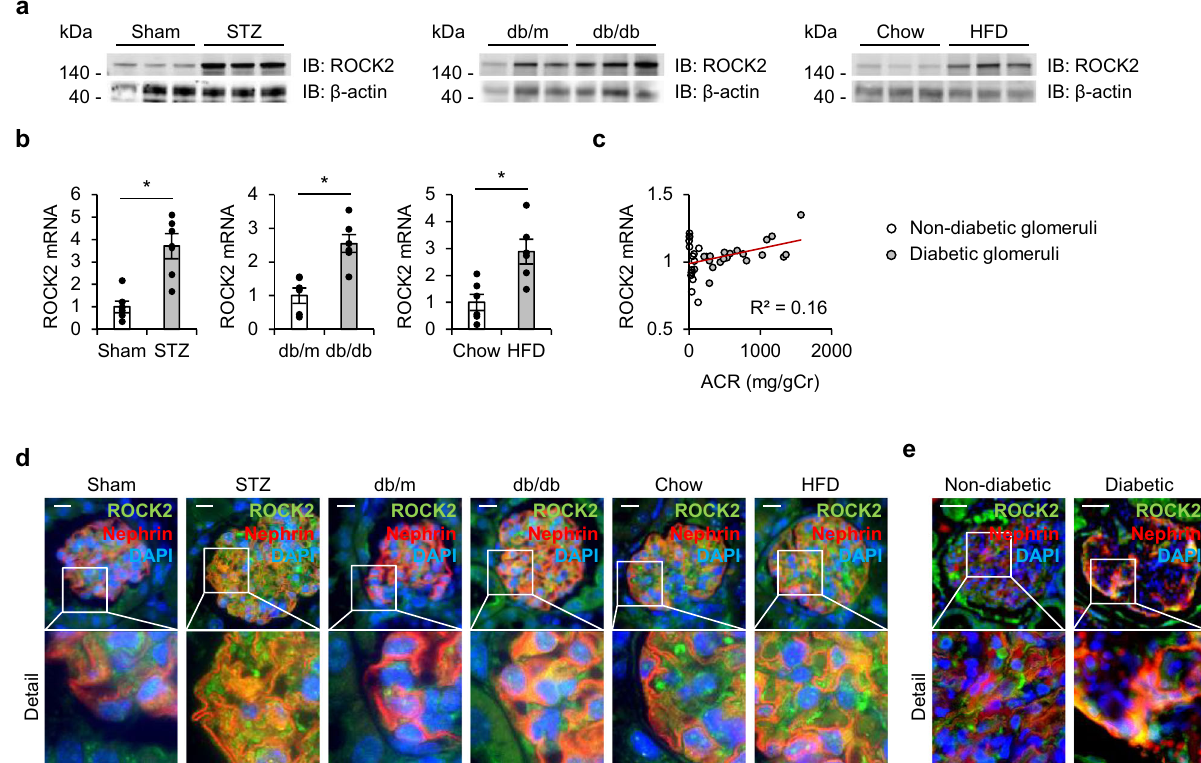
Fig. 1 Podocyte ROCK2 is upregulated in animal models of diabetes and in patients with diabetes. a ROCK2 levels in the renal cortex of streptozotocin (STZ)-injected mice, db/db mice, and mice treated with high-fat diet (HFD). b The expression levels of ROCK2 in isolated glomeruli. c A correlation analysis between glomerular ROCK2 mRNA and albumin-to-creatinine ratio (ACR). Hodgin Diabetes Mouse Glom data obtained from the transcriptomic database Nephroseq (https://www.nephroseq.com) were used. The trendline is shown in red. The R value was determined by Pearson correlation analysis; white and gray plots represent non-diabetic mice and diabetic mice, respectively ( n = 18 – 21). d Immunostaining of ROCK2 (green) and Nephrin (red) in the glomerulus of STZ-injected mice, db/db mice, and HFD-fed mice. Nuclei were visualized with DAPI (blue). The scale bar on the top left represents 10 μ m. e Immunostaining of ROCK2 (green) and Nephrin (red) in the glomeruli of patients without or with diabetes. Nuclei were visualized with DAPI (blue). The scale bar on the top left represents 50 μ m. * p < 0.05. Data represent the mean ±